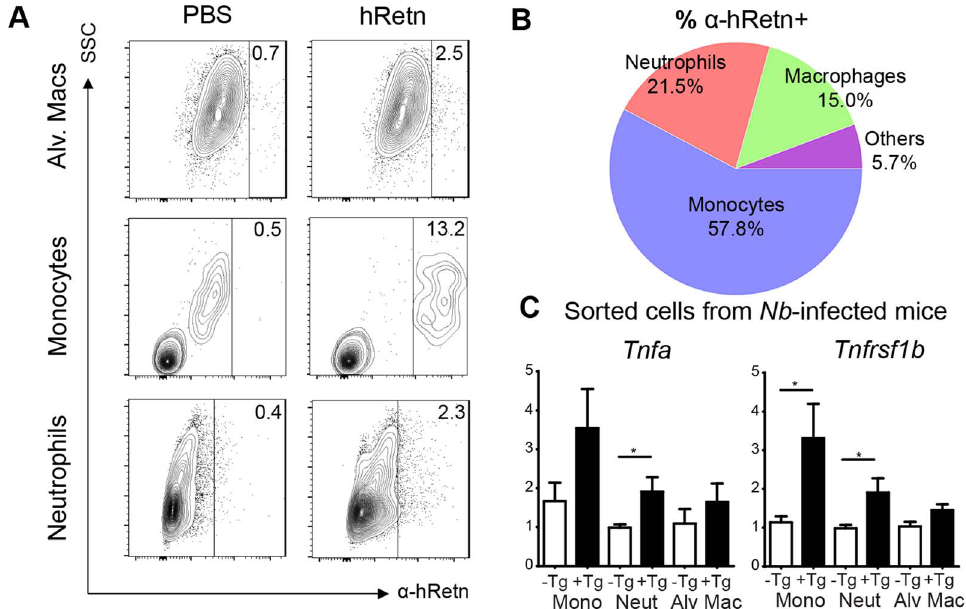
Fig. 6. Monocytes and neutrophils are the main cellular targets of hResistin during Nb infection. (A-B) Lung cells from Nb -infected mice were incubated with recombinant hResistin followed by detection with a -hRetn to determine which cells can bind hResistin compared with control PBS (A). Surface expression of the hResistin-bound cells identified monocytes as the main cell-type that bound hResistin (B). (C) Sorted lung cells from Nb -infected h Retn Tg 2 and h Retn Tg + mice were analyzed for proinflammatory gene expression by real-time PCR. Data (mean 6 SEM, n=3–4 per group) are representative of two separate experiments.